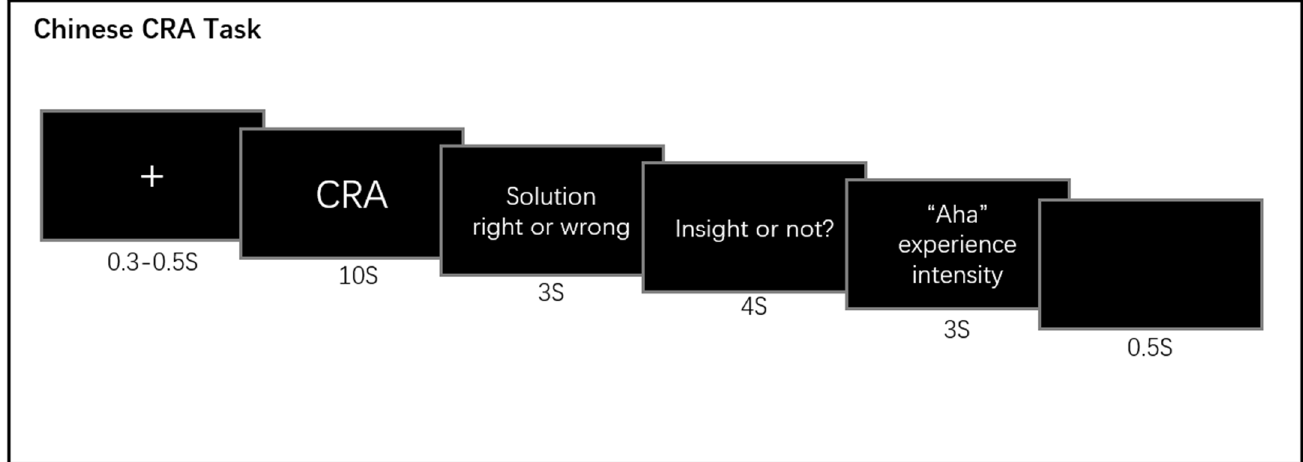
Figure 1. Experimental procedure: the solution test and re-solution test both are CRA